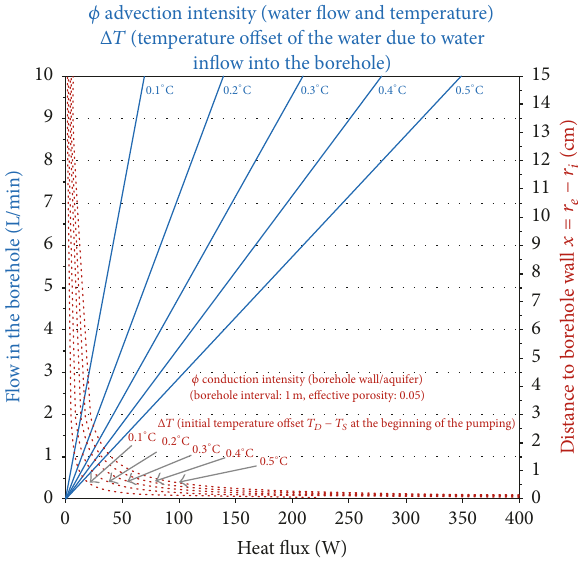
Figure 5: Comparison of advection and conduction heat fluxes at the borehole scale. Φ = 𝑓 (total flow rate, temperature offset advection due to groundwater inflow) and Φ = 𝑓 (distance of radial conduction temperature propagation into the aquifer, 𝑇 𝐷 − 𝑇 𝑆 offset). Figure 6: Example of 𝑇 𝑖 (𝑧) initialization prior to 𝑇 𝐷 (𝑧) modelling with the heat